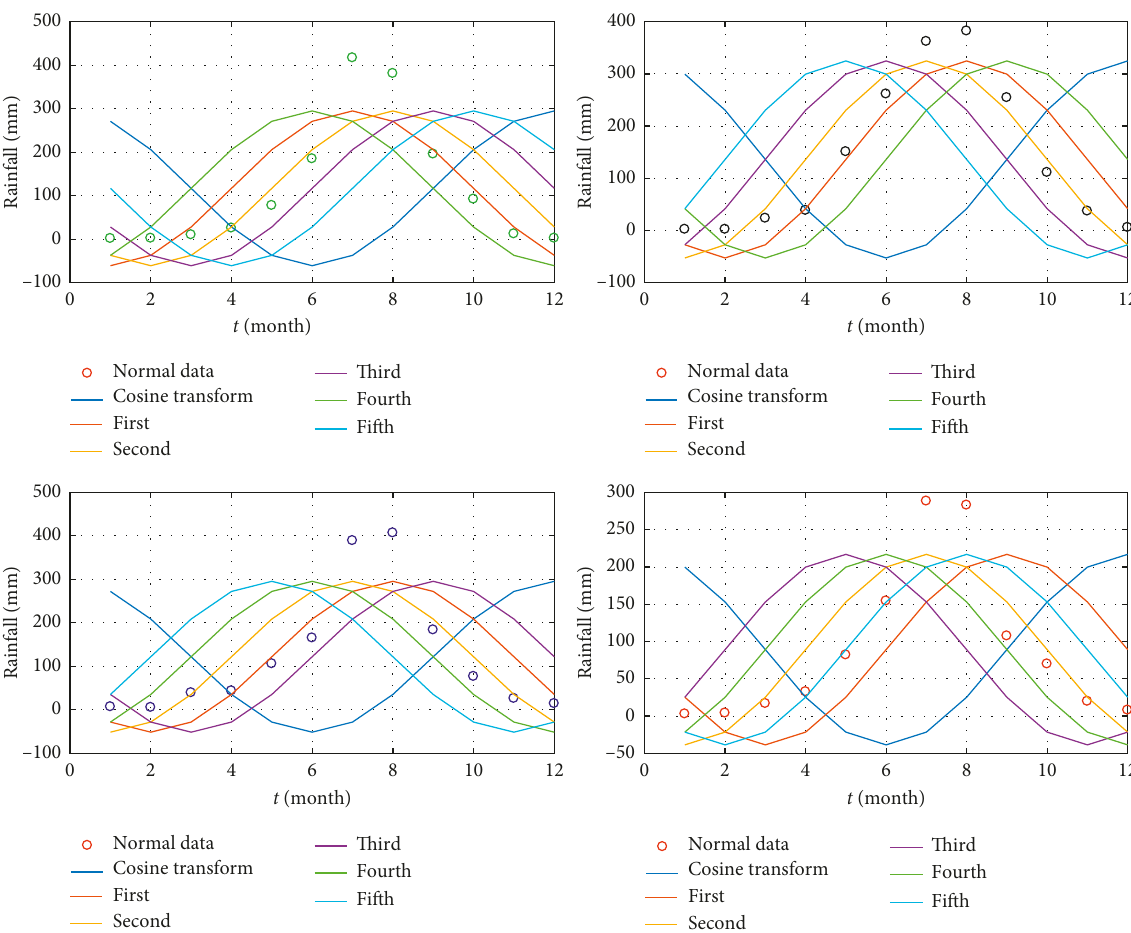
Figure 3: Illustration of the approximate matching of a cosine function to a data detail about the lines. (a) Bahir Dar, (b) Dangila, (c) Debre Tabor, and (d) Gondar.